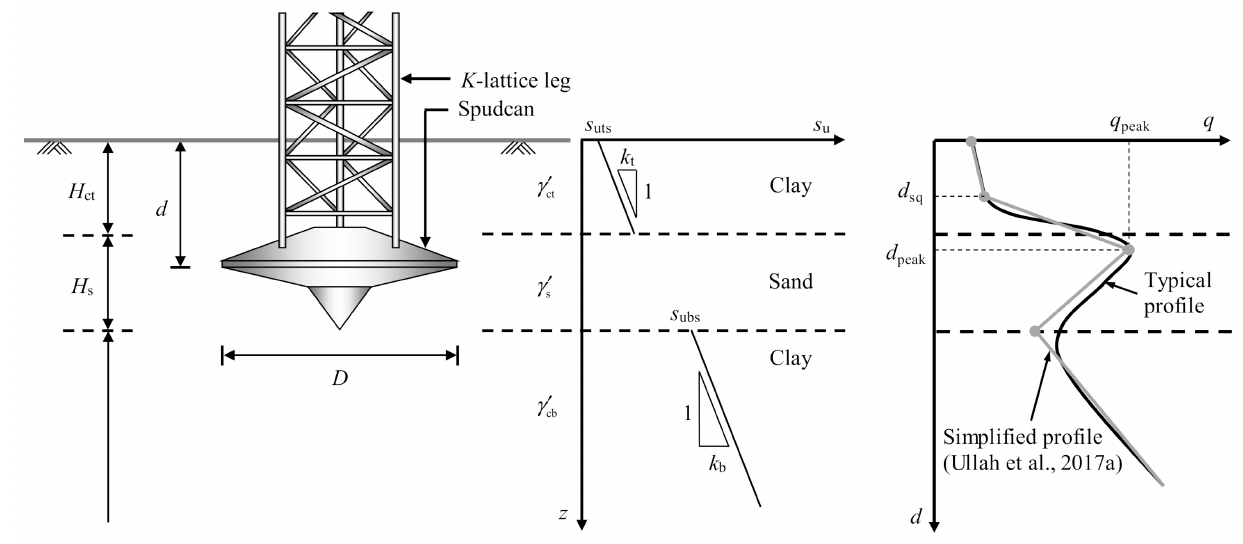
Figure 1. Illustration of spudcan in clay–sand–clay deposit and corresponding typical penetration resistance